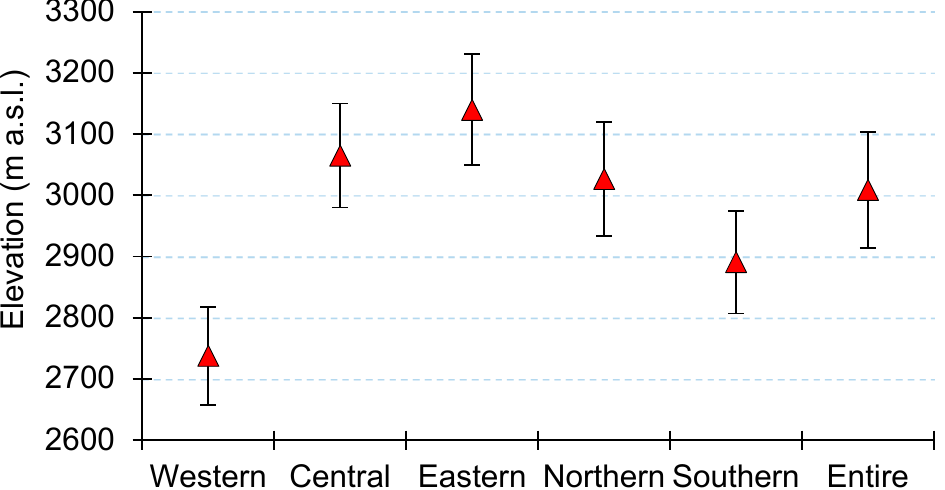
Figure 6. Mean average elevation of all rock glaciers inventoried across the Greater Caucasus according to the different sections (western, central, and eastern) and slopes (northern and southern). Error bars are based on standard deviation (1 σ ). The difference between the mean average surface slope was minor between active (41.4 ± 3 ◦ ) and relict (38.8 ± 4 ◦ ) rock glaciers in the entire mountain region, as it is within the uncertainty. Some differences in slope were present between the different sections, e.g., rock glaciers in the western Greater Caucasus had the least inclined surface with the mean average slope of 35.9 ± 4 ◦ , while the central and eastern had relatively higher slope (42.7 ± 3 ◦ and 42.2 ± 3 ◦ , respectively). The difference in the mean average surface slope was also insignificant between southern and northern slopes. Rock glaciers found on the southern slopes had the mean average slope of 43.4 ± 3 ◦ , while the northern counterparts had the mean average slope of 40.2 ± 3 ◦ (Figure 8a). Figure 8b shows the spatial